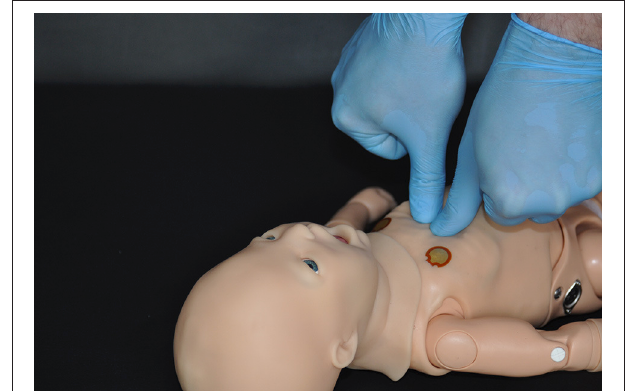
FIGURE 1 | The new newborn chest compression